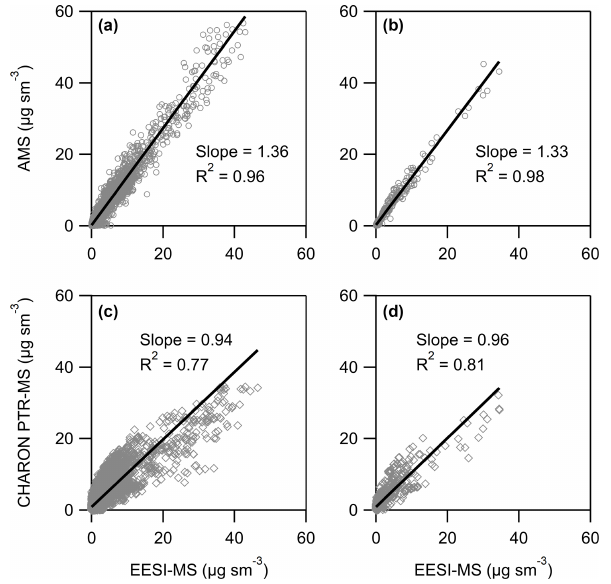
Figure 7. Comparison of EESI-MS quantification of levoglucosan (C 6 H 10 O 5 Na + ) to AMS equivalent levoglucosan at (a) 1s and (a) 10s time resolution and to CHARON PTR-MS levoglucosan at (c) 1s and (d) 10s time resolution during a single FIREX-AQ flight.